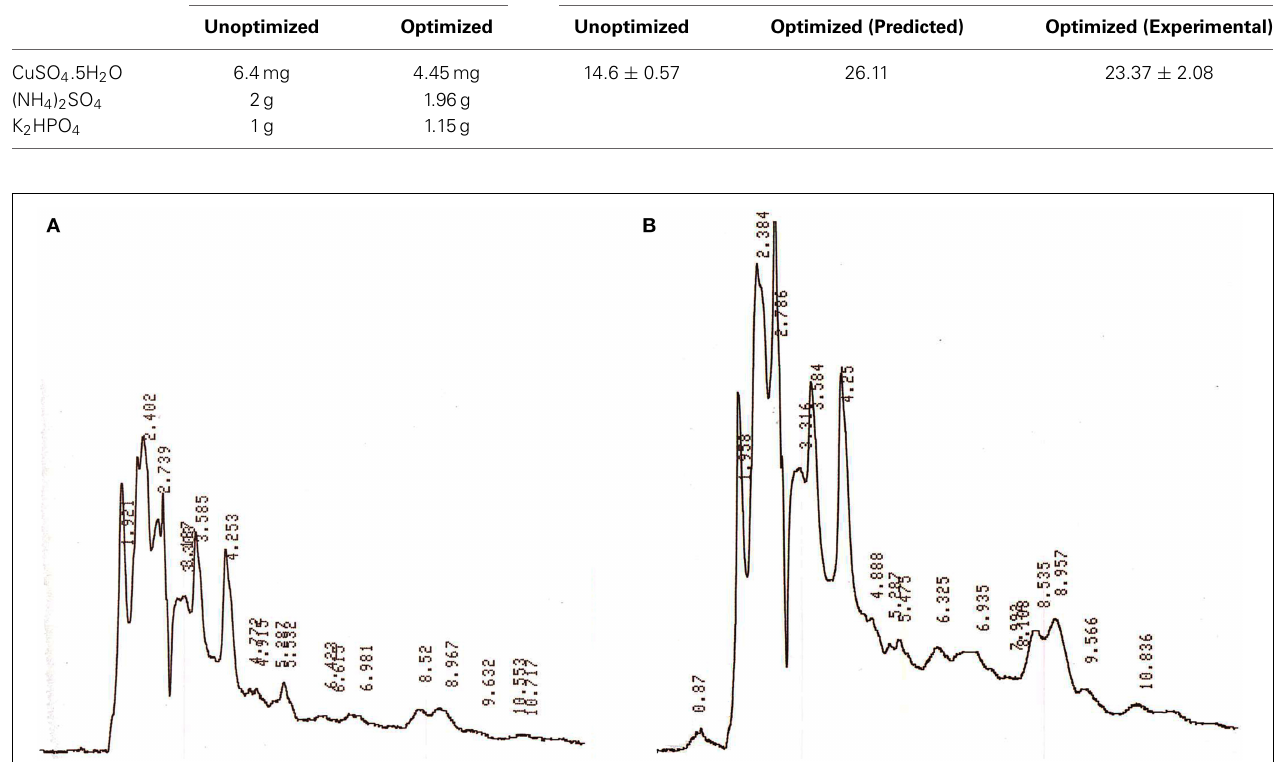
FIGURE 8 | HPLC profiles of secondary metabolites extracted from Streptomyces sp. JAJ13 culture broth under (A) unoptimized and (B) optimized levels of media